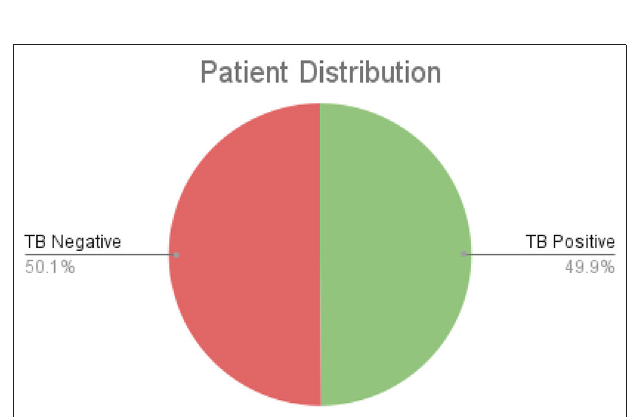
FIGURE 2 | The comparison of TB positive vs. TB negative samples in the dataset. As shown, the split is roughly